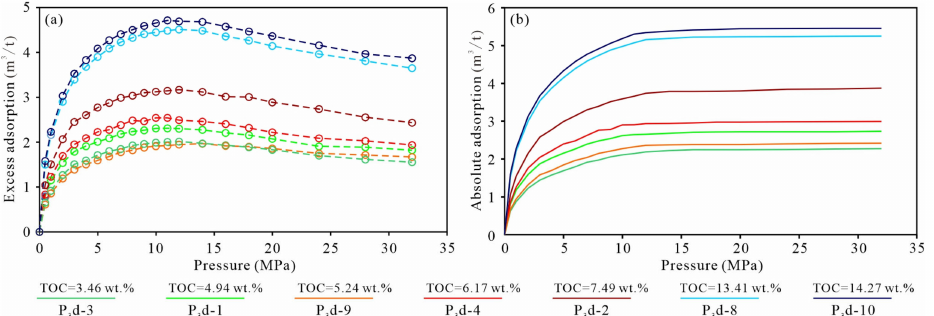
Figure 15. ( a ) Excess and ( b ) Absolute methane adsorption isotherms for the Dalong Formation shale samples from well